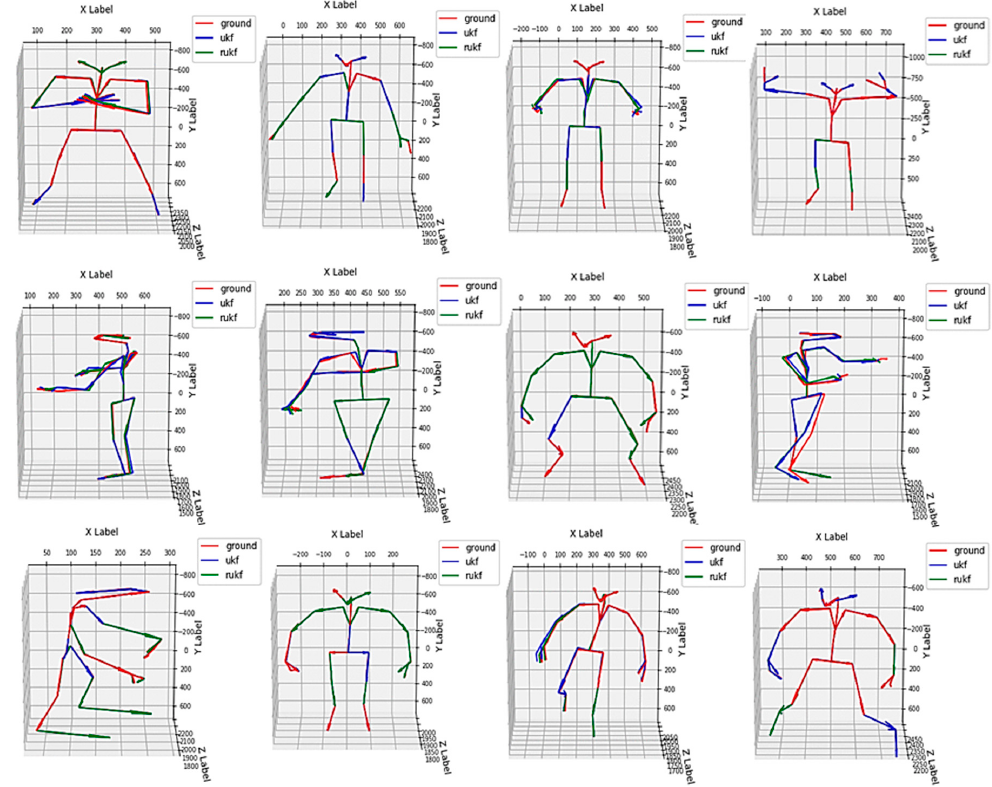
Figure 5. Results of 3D skeleton estimation using UKF and the proposed method. The skeleton estimation by the UKF and RUKF method is indicated as blue and green lines, respectively. These captured images are shown only single frame among 30-s in each pose. Therefore, there are some limitations to showing the experiments entirely. However, it is possible to evaluate the performance of the RUKF method using Table 1. The 3D skel- eton map estimation by the proposed method has better results in terms of the quantita- tive results of RMSE_mean (±SD) than that of the UKF method in Figure 5. 5. Conclusions This study proposed a method of 3D skeleton pose estimation using a randomized unscented Kalman filter to reduce nonlinear noises on a Kinect camera. The proposed method analyzed the propagation and updating process for temporal noises of skeleton data on the x, y, and z-coordinate systems. The accuracy of state estimation and prediction of the data are enhanced owing to the use of randomized UT. This enables the proposed method to correct errors that occur with the nonlinear temporal noise. Therefore, the ex- perimental results show that the performance of the proposed method reduces the RMSE and SD while estimating the 3D skeleton map. Author Contributions: Conceptualization, Y.R.M. and O.-S.K.; methodology, Y.R.M. and O.-S.K.; investigation, Y.R.M. and O.-S.K.; writing—original draft preparation, Y.R.M.; writing—review and editing, Y.R.M. and O.-S.K.; supervision, O.-S.K.; project administration, O.-S.K. All authors have read and agreed to the published version of the manuscript. Funding: This research was supported by Basic Science Research Program through the National Research Foundation of Korea (NRF) funded by the Ministry of Science, ICT and Future Planning (2019R1F11058489).